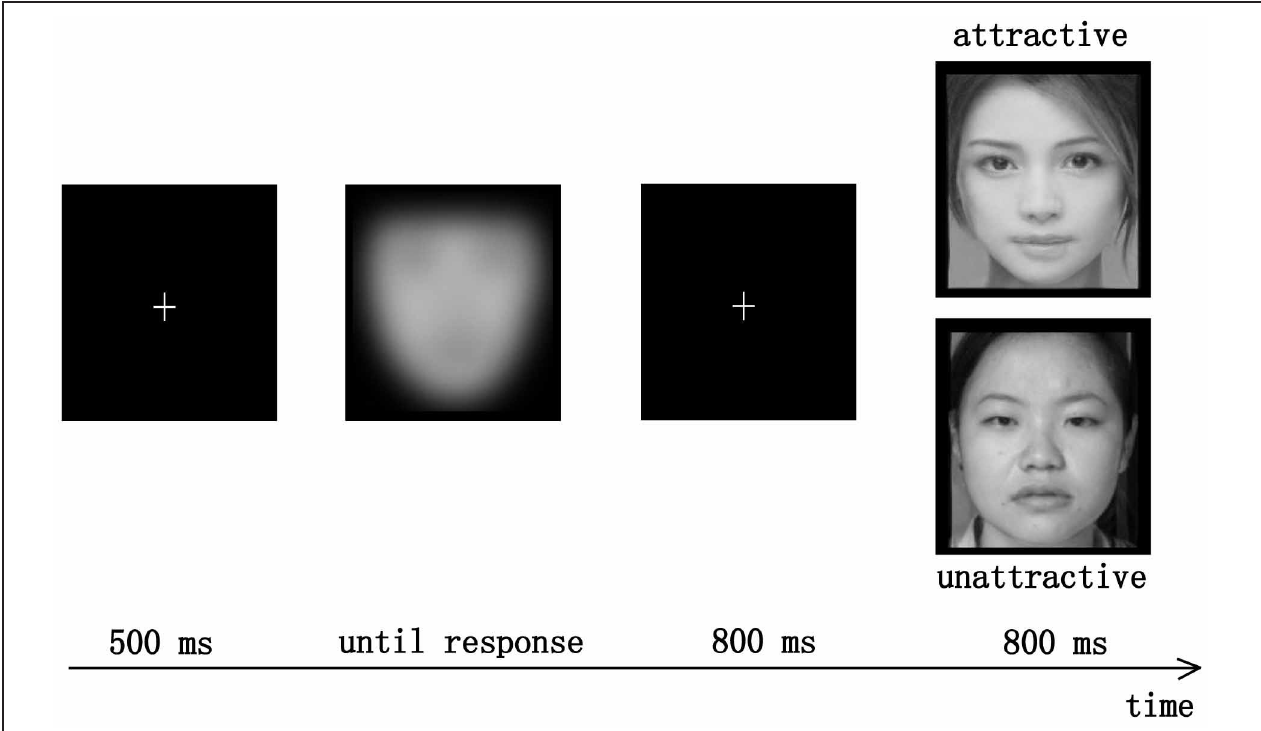
FIGURE 1 | Sequence of events in a single trial. For illustration purpose, the attractive and the unattractive faces in the figure are the ones morphed from several faces used in the experiment.